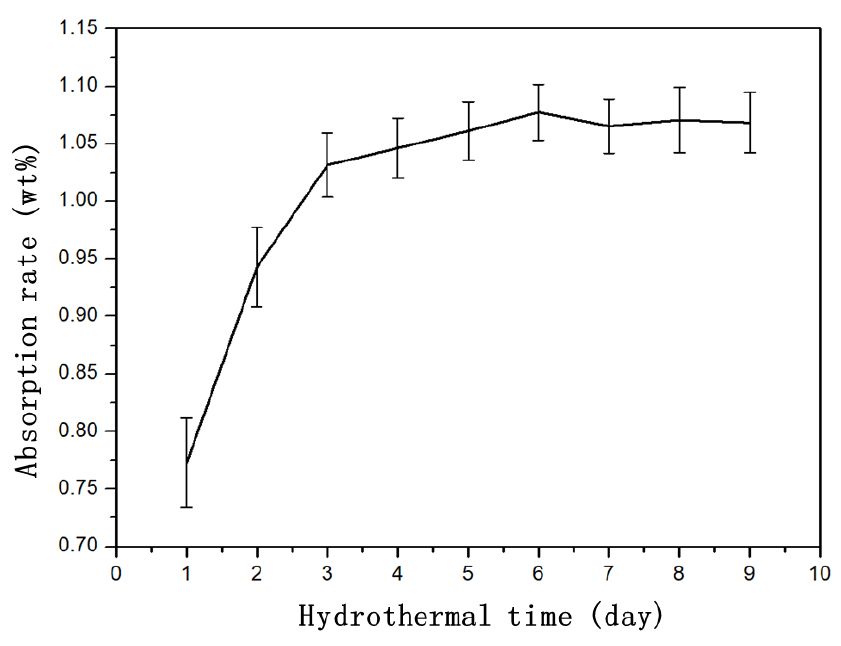
Figure 5. Relationship between the moisture absorption rate of CFRE samples and the hydrothermal treatment